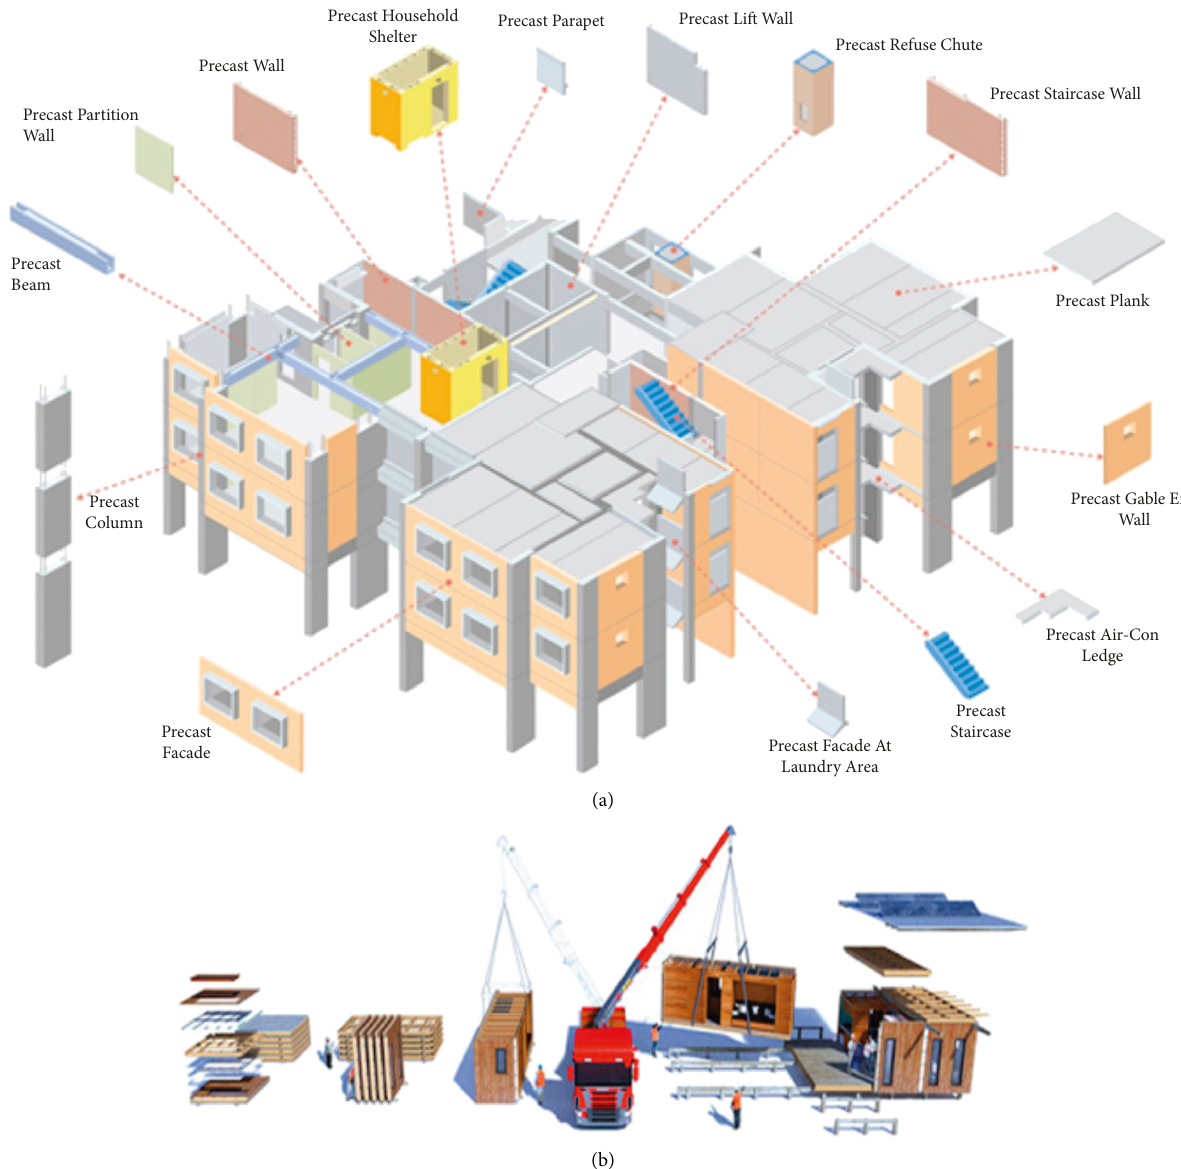
Figure 3: (a) Prefabricated construction [18]. (b) modular construction using 3D element.